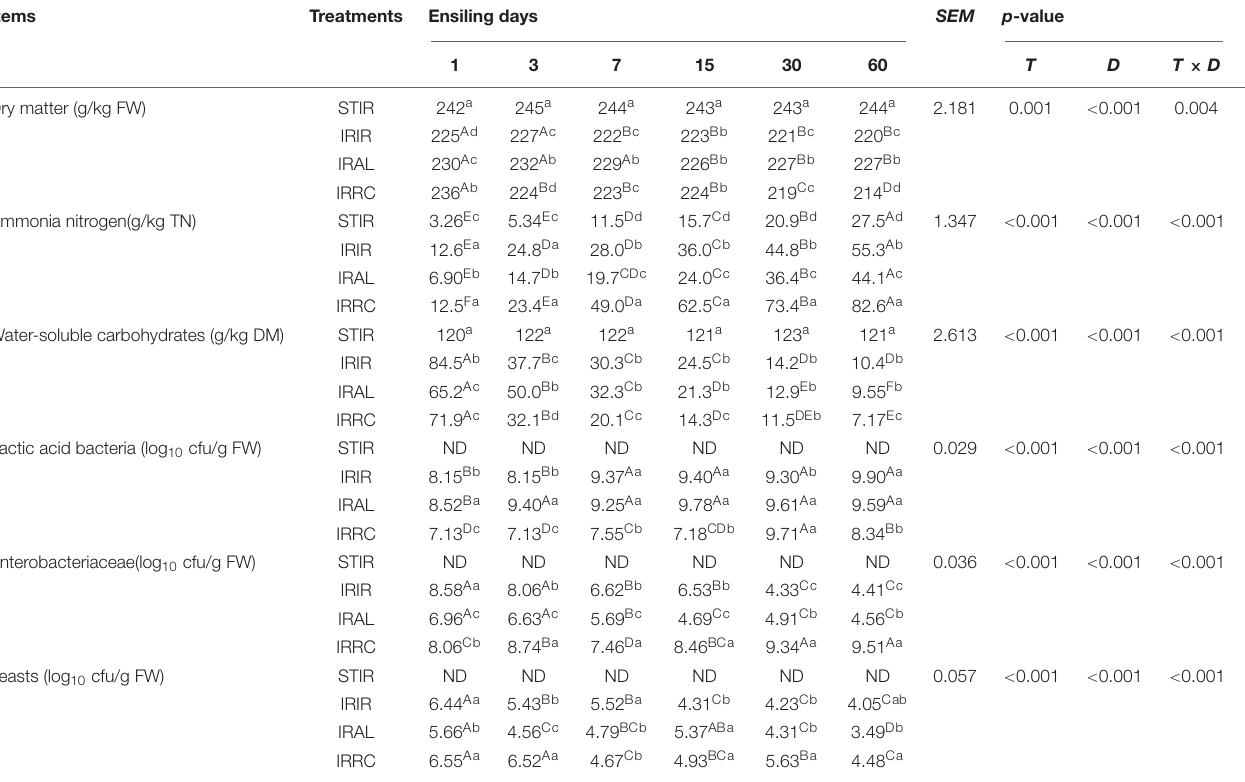
TABLE 3 | Effects of exogenous microbiota on chemical and microbial compositions in Italian ryegrass silages. Items Treatments Ensiling days